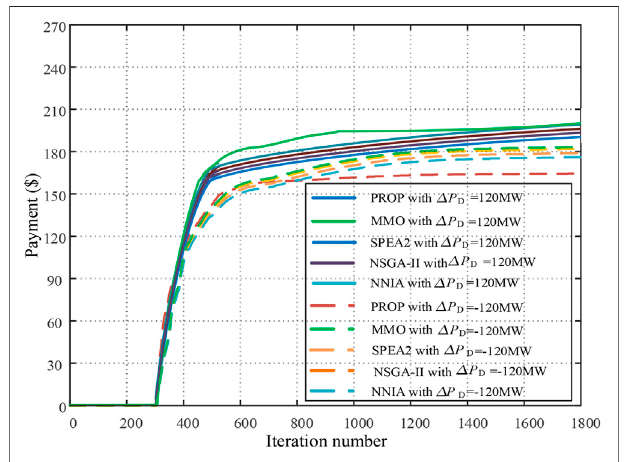
FIGURE 8 | Adjustment mileage payment under four perturbations cases.